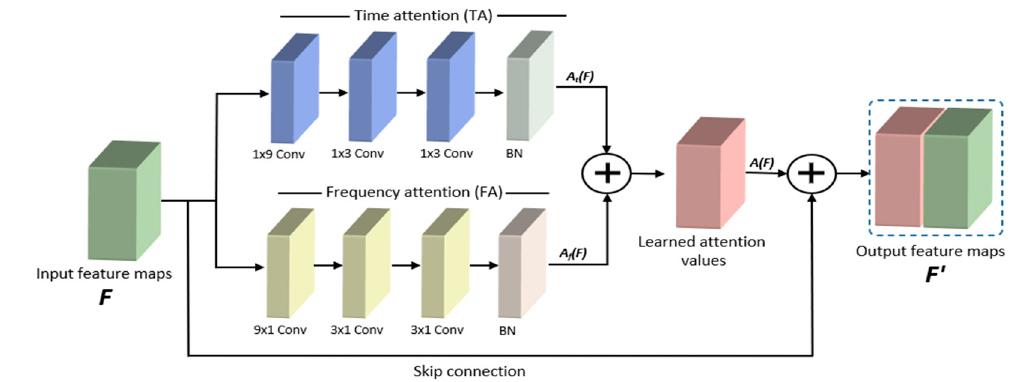
Figure 3. A detailed overview of the MAM module structure. Input feature maps fed to time and frequency attention modules to capture the critical parts of both time and frequency features. Learned attention values are concatenated with input feature maps using a skip connection to produce output feature maps.